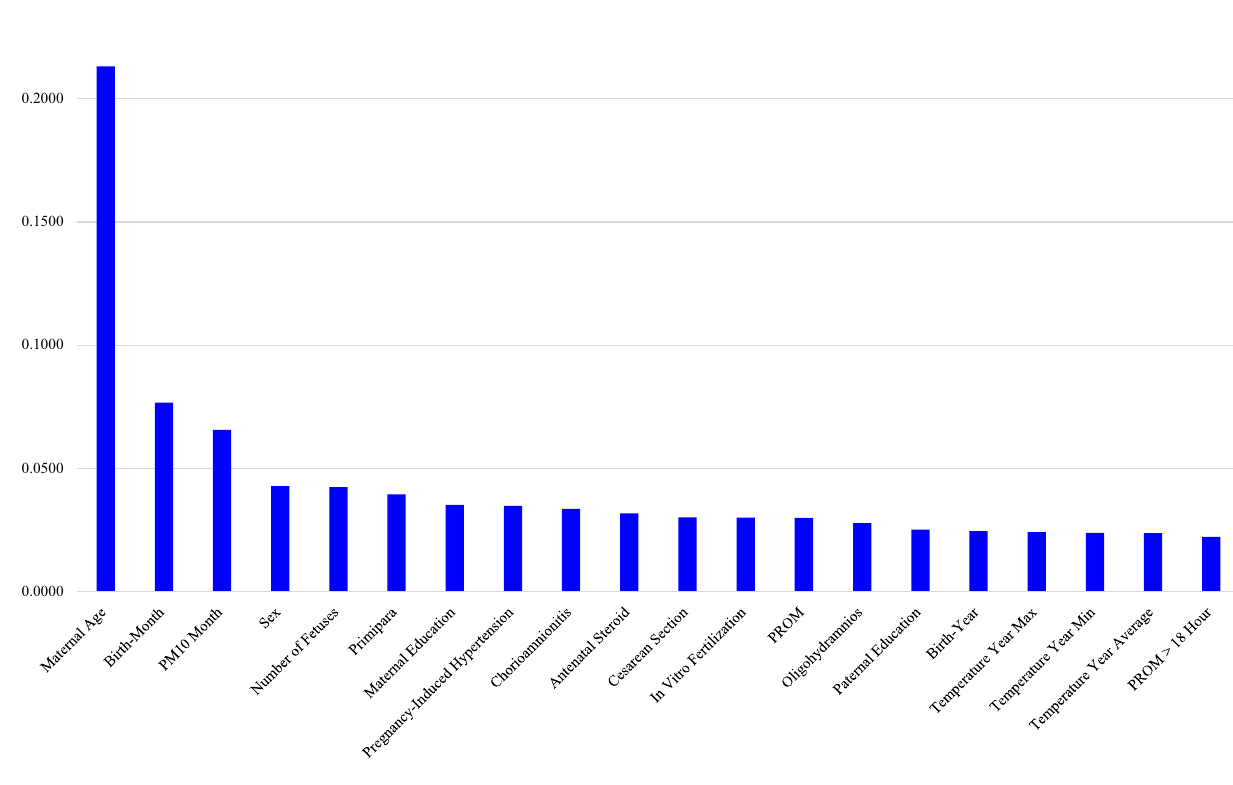
Figure 1. Random forest variable importance plots for adverse birth outcomes: PM 10 included. PM, particulate matter; PROM, prelabor rupture of